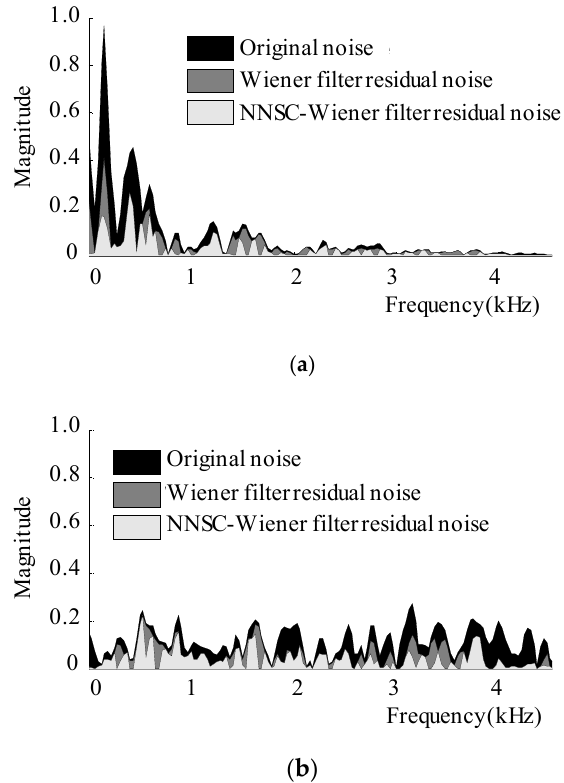
Figure 6. The comparison of the spectral residual noise remaining after the application of the conventional Wiener filter and proposed NMF-based Wiener filter method to ( a ) babble and ( b ) Gaussian noisy speech at an SNR of 5 dB.